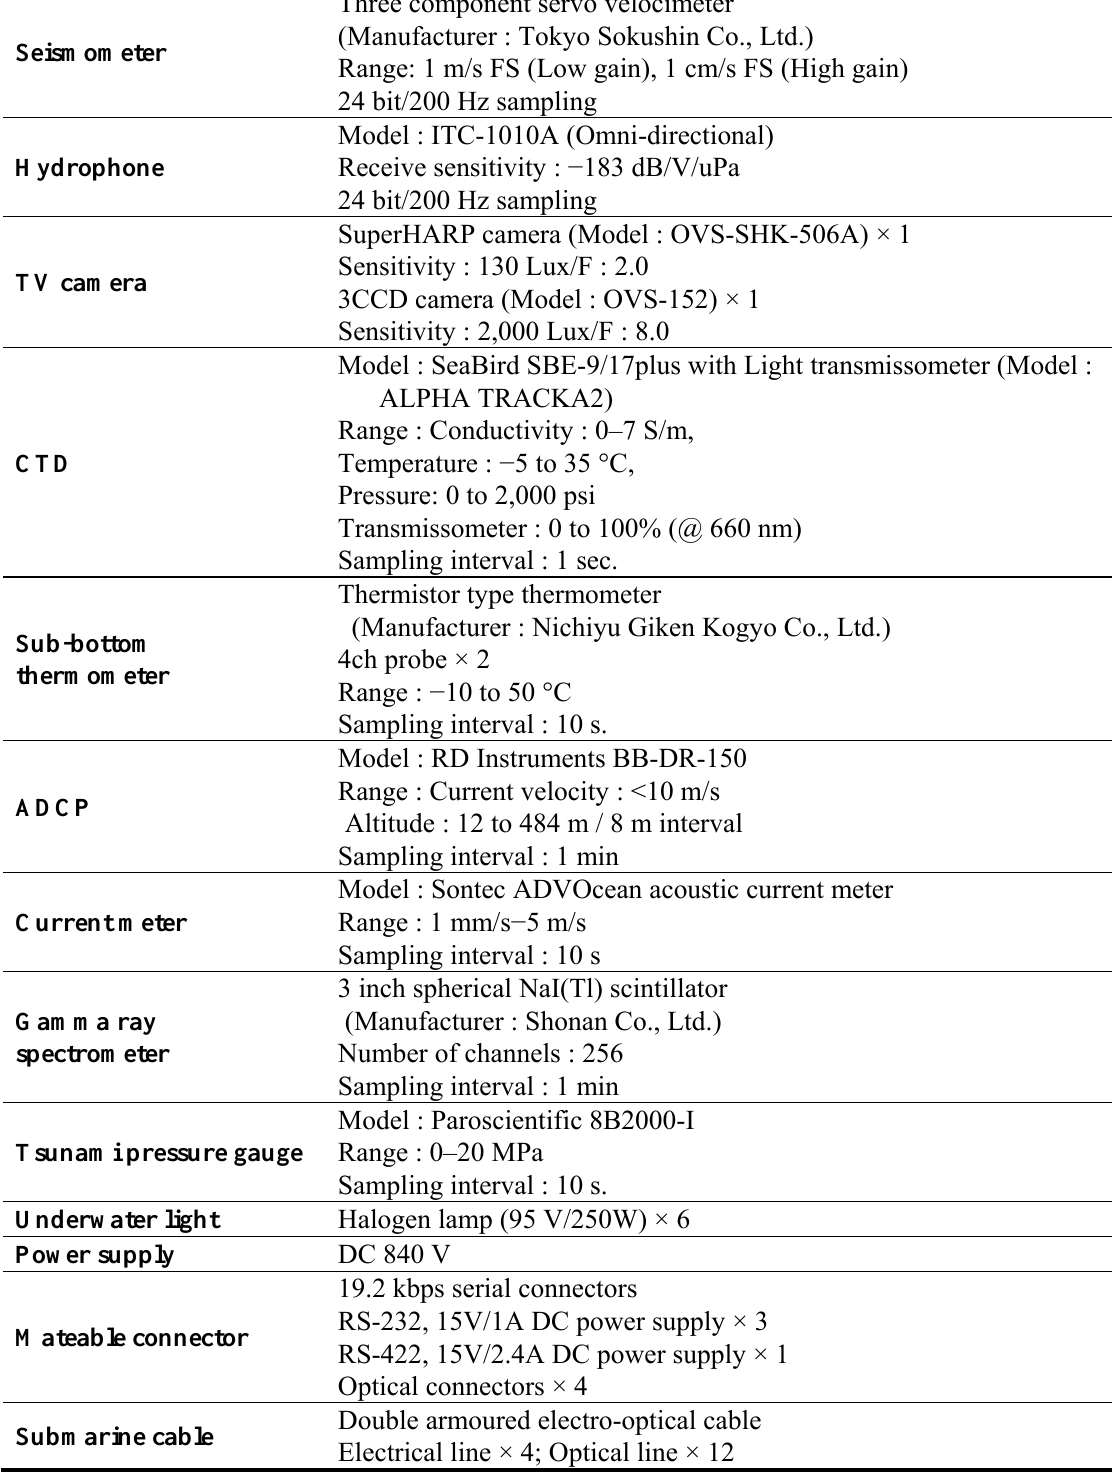
Table 1. Specifications of the “off-Hatsushima